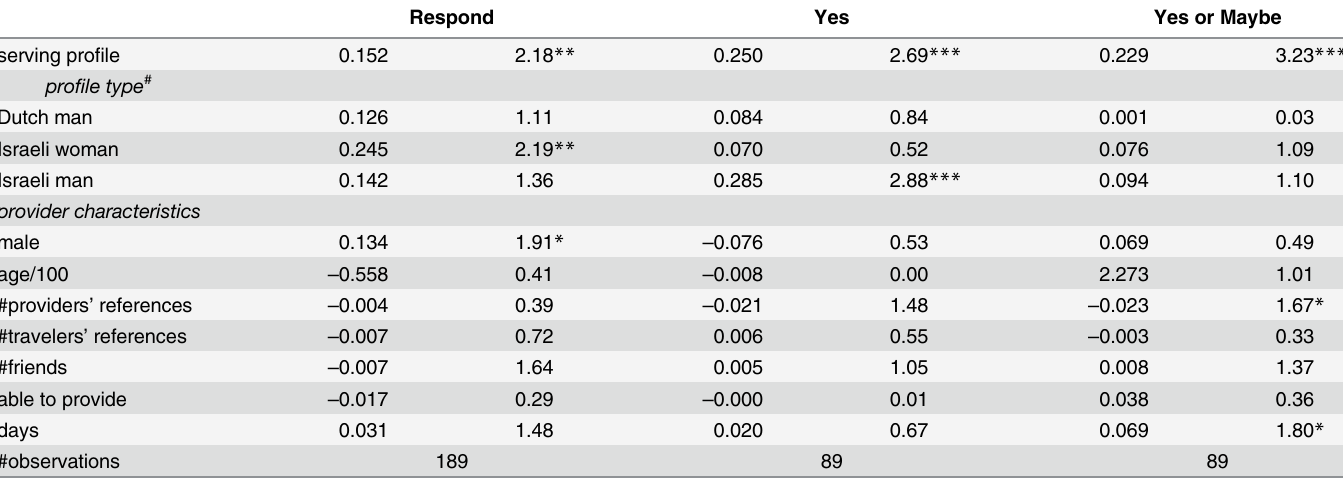
Table 2. Determinants of Providers ’